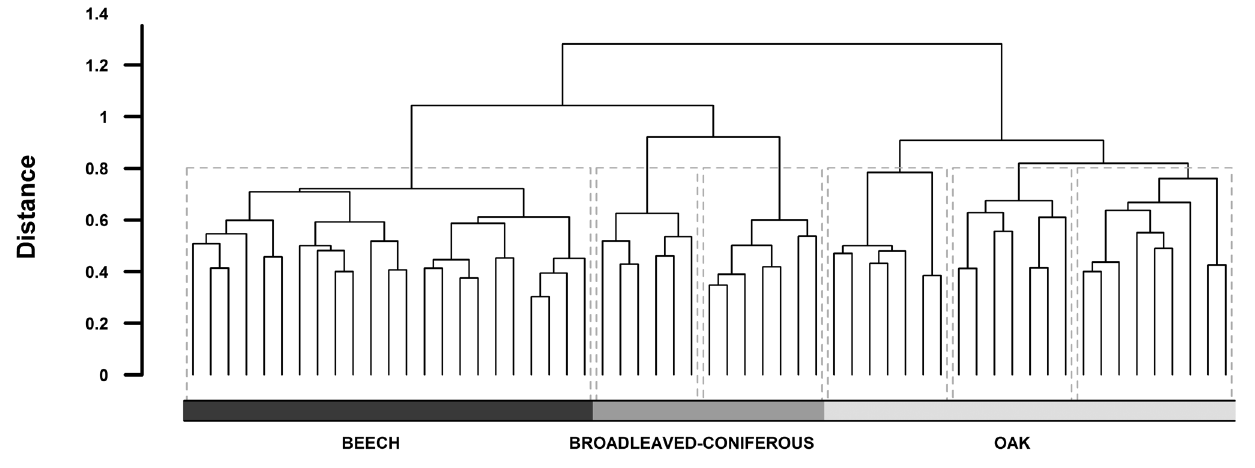
Figure 2 – Dendrogram of numerical classification of fungal assemblages (generated via hierarchical clustering of 59 plots in different forest ecosystems). The main forest types (beech, oak and broadleaved-coniferous) are